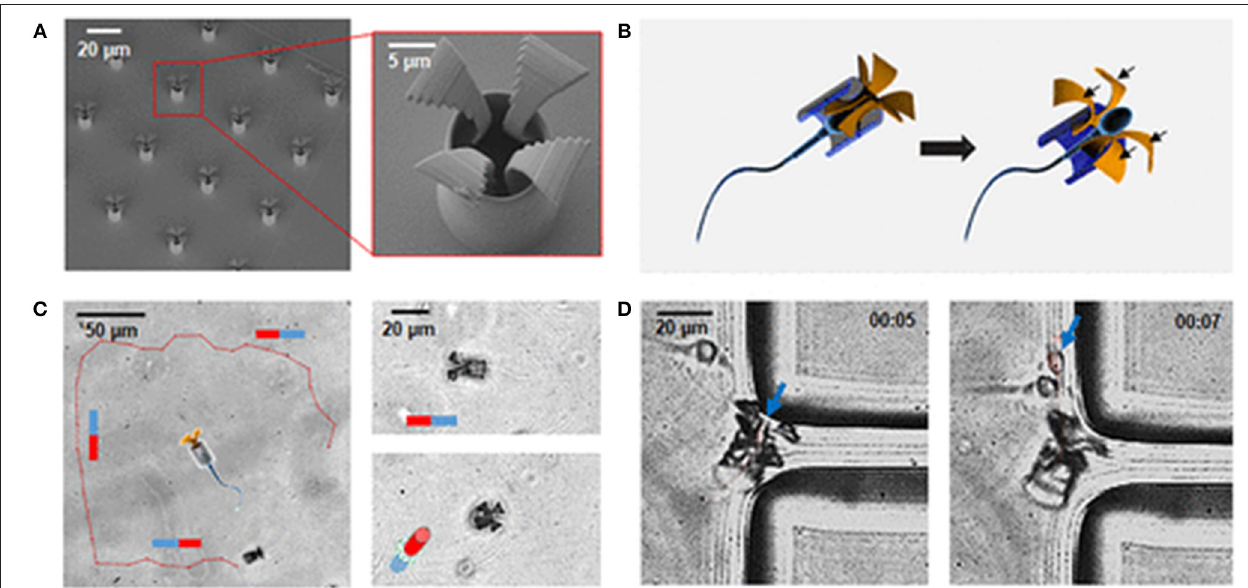
FIGURE 1 | (A) SEM images of an array of printed tetrapod microstructures. (B) Schematic illustrating the mechanical release mechanism. (C) Track (red line) of a sperm-hybrid motor under magnetic guidance in the horizontal and vertical planes. (D) Image sequence of a sperm release process when the arms hit the corner of a polydimethylsiloxane wall. Blue arrows point at the sperm head. Time lapse in min:s ( Xu et al., 2018). Reproduced with the permission of the copyright holder [American Chemical